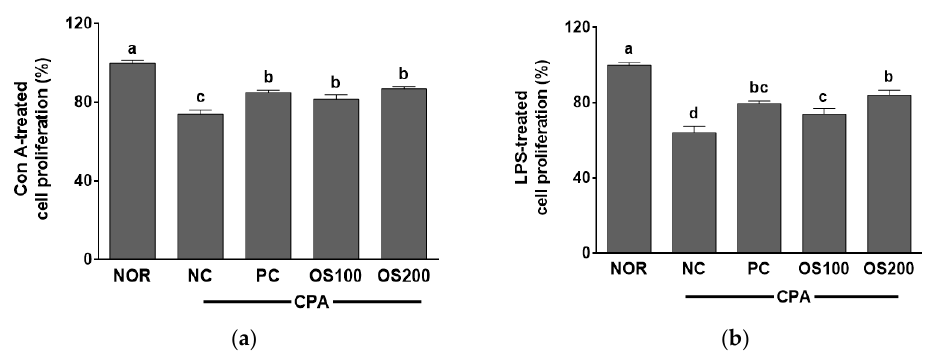
Figure 9. Effects of A. cepa skin (OS) extracts on the proliferation of splenocytes treated with ( a ) Con A and ( b ) LPS in the C57BL/6 mice immunosuppressed by cyclophosphamide (CPA). NOR, normal control group; NC, negative control group; PC, positive control group; OS100, OS extract 100 mg/kg BW; OS200, OS extract 200 mg/kg BW. Data was expressed as the mean ± SEM. a–d Different letters are significantly different at p < 0.05.